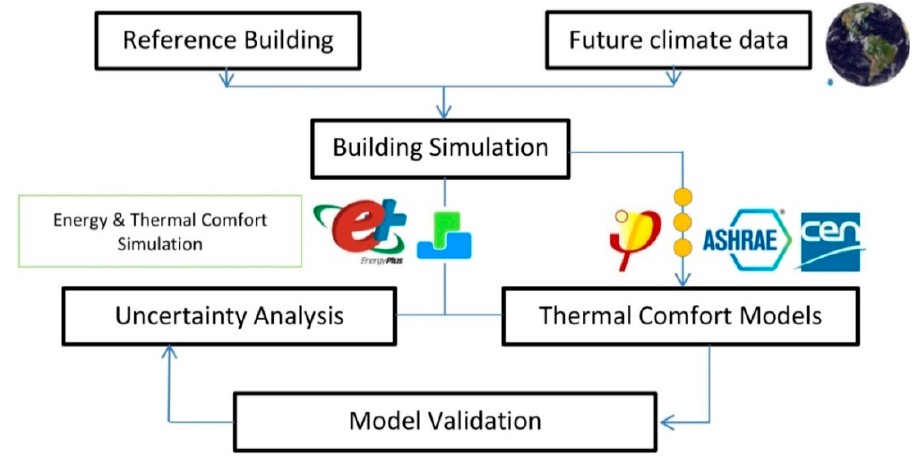
Figure 2. Conceptual study framework.